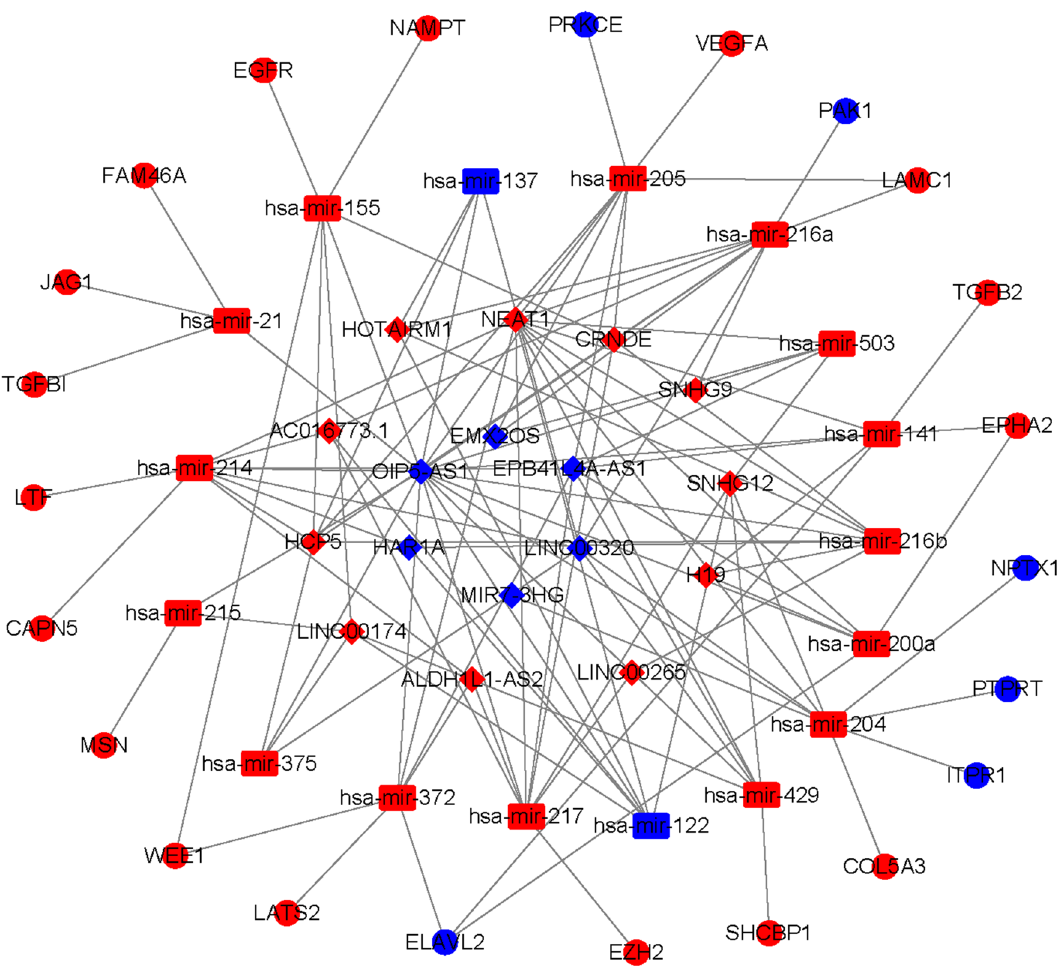
Figure 8. The ceRNA regulation network based on differentially expressed mRNA, lncRNA, and miRNA between high- and low-risk groups in TCGA dataset (red: up-regulation. blue: down-regulation; circle: mRNA, rhombus: lncRNA, rectangle: